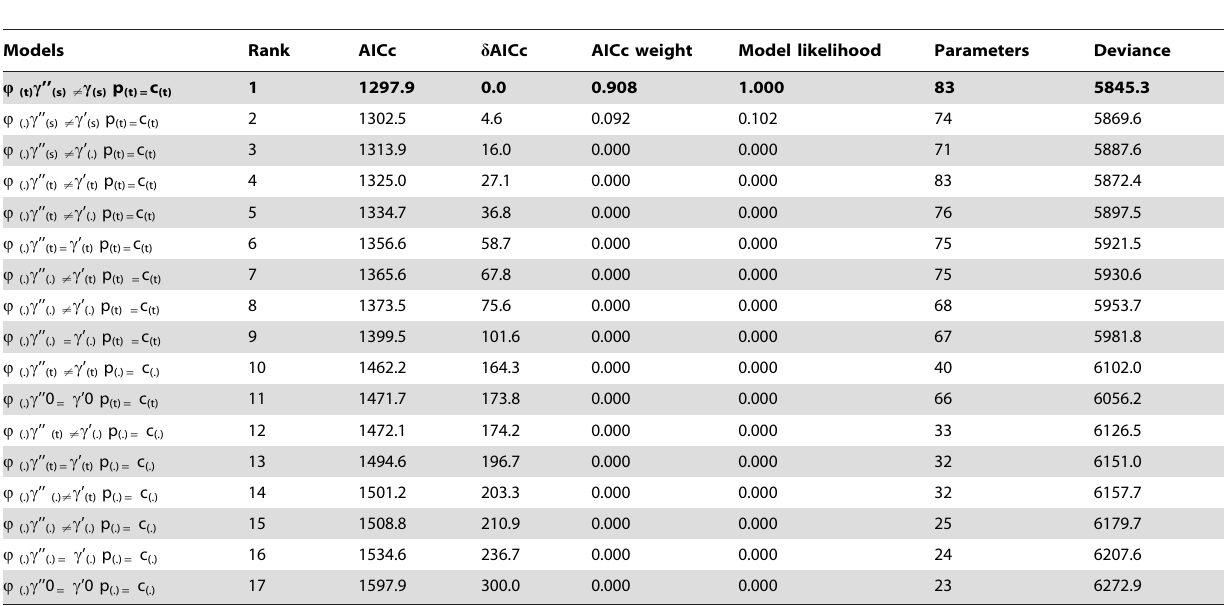
Table 6. Capture-recapture models fitted to the capture histories of all juvenile and adult dolphins combined estimate parameters for population size (N), apparent survival ( Q ), temporary emigration ( c ’’, c ’) and capture probability (p).